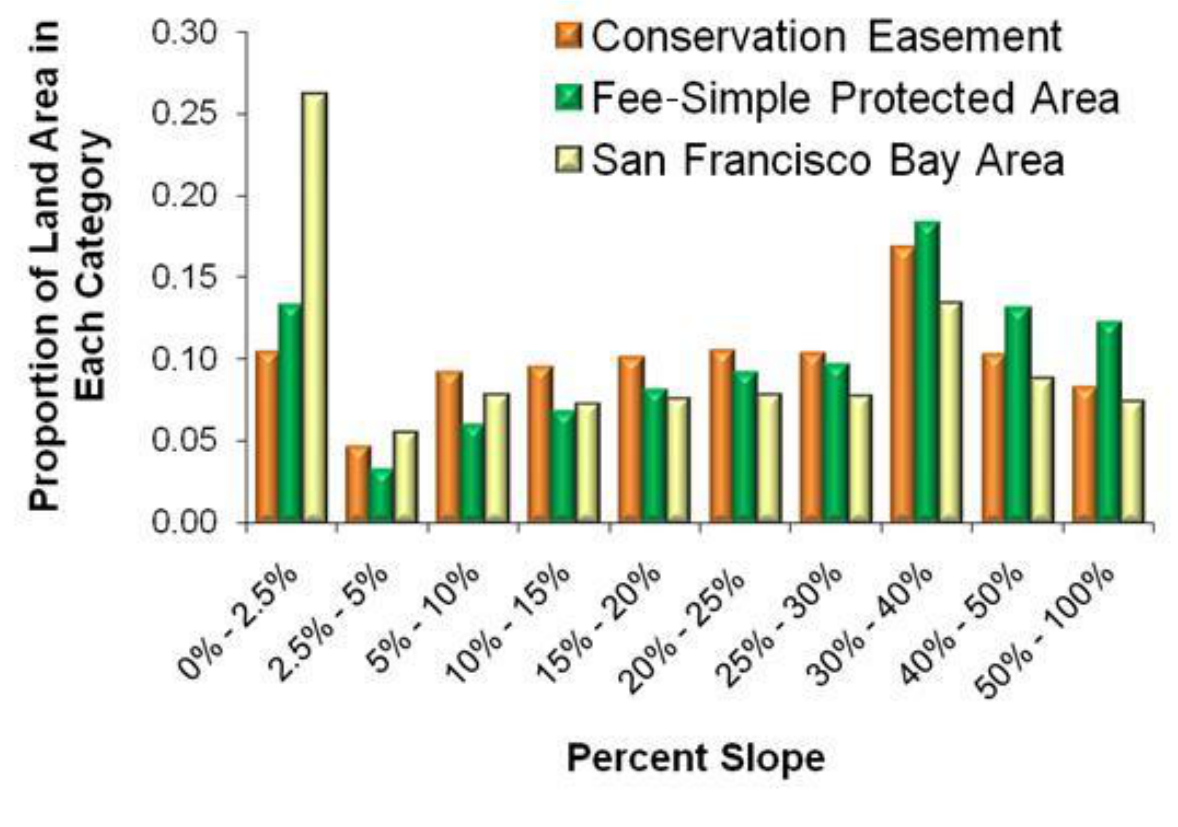
Fig. 7 . Slope distribution for conservation easements, fee-simple properties, and all land in the San Francisco Bay Area, excluding bodies of